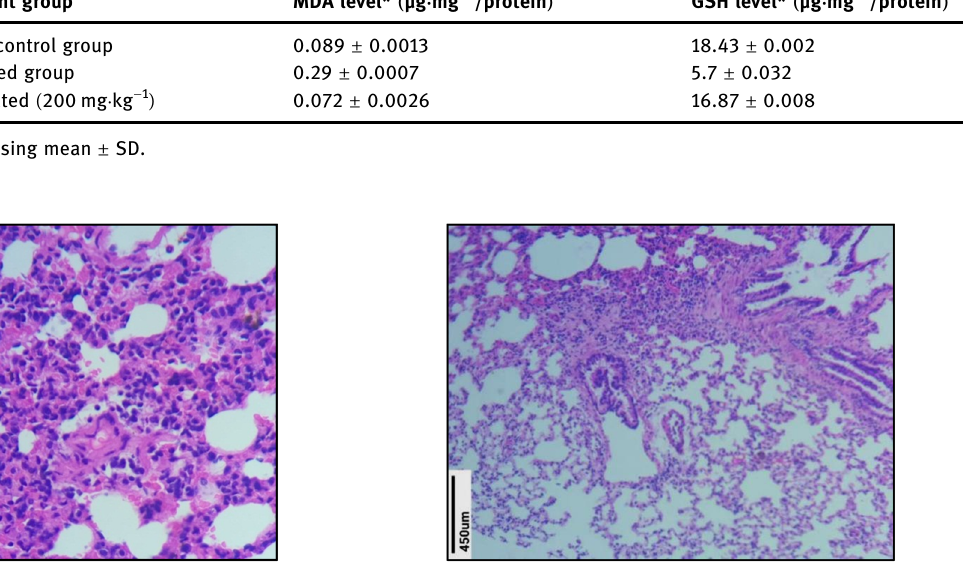
Figure 4: Histopathological study of Group V lung section ( control group ) . No changes were observed in the normal control group.